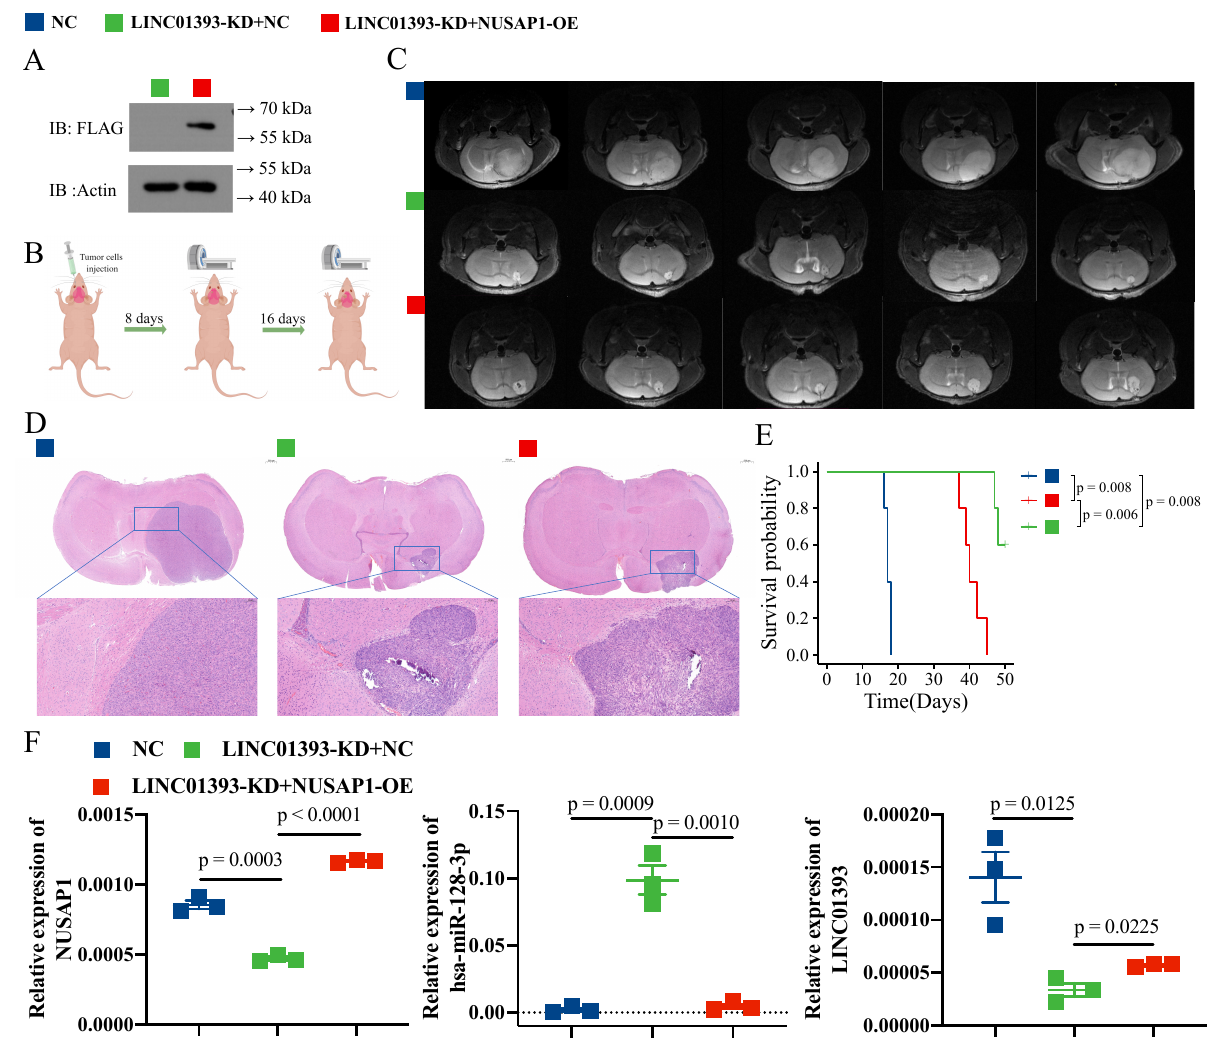
Figure 6. Knockdown of LINC01393 inhibits GBM Progression in vivo. ( A ) Western blot confirmation of NUSAP1 protein expression in U87-LINC01393-KD+NC and U87-LINC01393-KD+NUSAP1-OE cells. ( B ) Schematic view of orthotopic intracranial glioma model. ( C , D ) Representative axial T2- weighted MR images at 16 days ( C ) and hematoxylin and eosin (H&E) staining ( D ) of xenograft GBM tumors in normal control, LINC01393-KD+NC, and LINC01393-KD+NUSAP1-OE groups. ( E ) Survival curves of mice bearing normal control, LINC01393-KD+NC, and LINC01393-KD+NUSAP1- OE groups. ( F ) qRT-PCR analysis of LINC01393, miR-128-3p, and NUSAP1 levels in tumor tissues of nude mice injected with normal control, LINC01393-KD+NC, and LINC01393-KD+NUSAP1-OE. 2.7. LINC01393/miR-128-3p/NUSAP1 Axis induce NF- κ B Pathway Activation GSEA based on NUSAP1 and LINC01393 expression in the TCGA LGG-GBM database was performed to explore the potential molecular pathways in gliomas. Interestingly, upregulated NUSAP1 and LINC01393 were both associated with NF- κ B signaling pathway (Figure 7A). The expressions of p65 and phosphorylated p65 in NF- κ B signaling path- way were further detected by immunoblotting. The result revealed that phosphorylated p65 expression decreased in LINC01393-KD+NC cells, while NUSAP1 overexpression could restore the phosphorylation of p65 (Figure 7B). These findings demonstrate that LINC01393/miR-128-3p/NUSAP1 axis induce the NF- κ B pathway